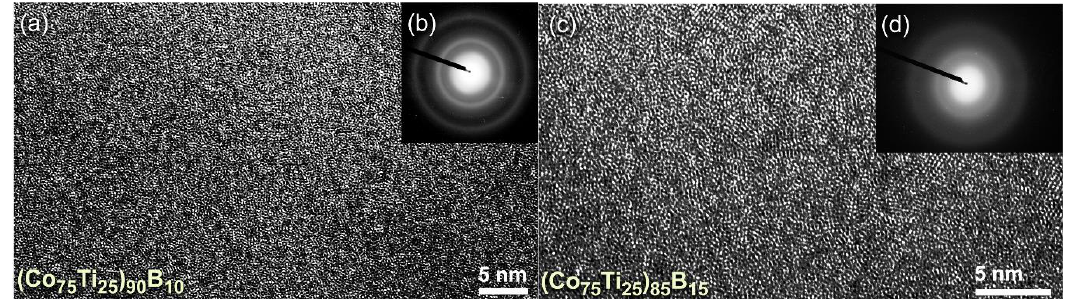
Figure 5. ( a ) FE-HRTEM, and ( b ) NBDP of (Co 75 Ti 25 ) 90 B 10 powders obtained after 50 h of MA time (end-product). The FE-HRTEM and corresponding NBDP for the end-product of (Co 75 Ti 25 ) 85 B 15 are displayed together in ( c ) and ( d ),